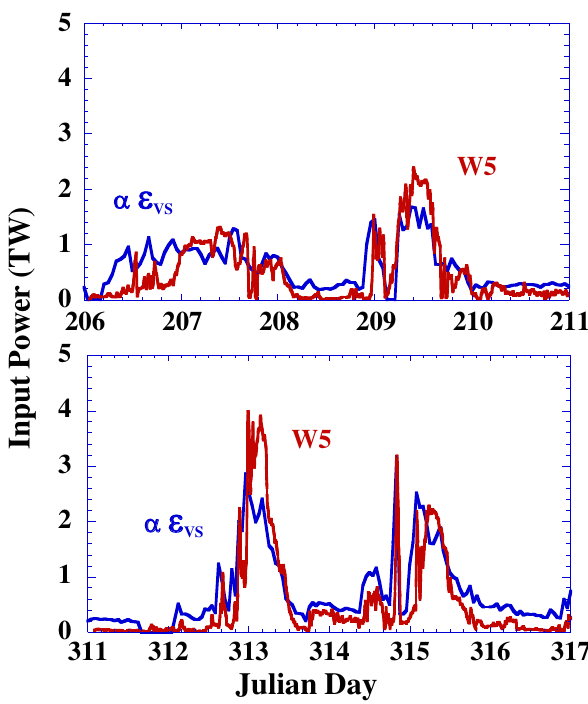
Fig. 8. Comparison of global power into the stormtime thermo- sphere predicted by the W5 model (red) and α ε VS (black) plotted as functions of time during the magnetically disturbed periods of July (top) and November (bottom)